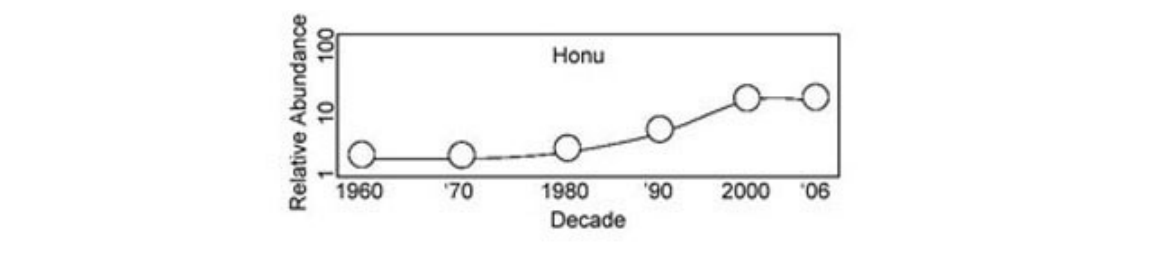
Fig. 2. With consistent distribution, honu (Hawaiian green turtle, Chelonia mydas ) have experienced increases in abundance since protections three decades ago. This represents an exception to the subsistence social-ecological guild and ornamental social-ecological